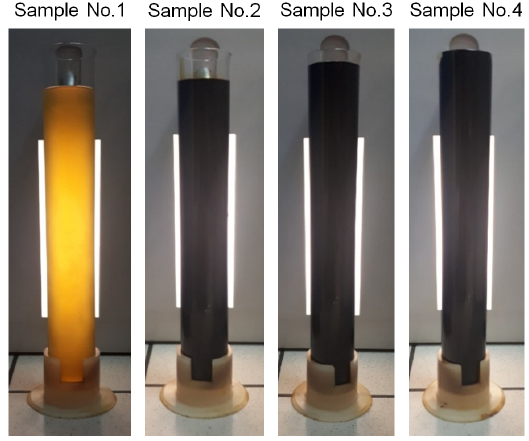
Figure 2. Samples of marine residual fuels.